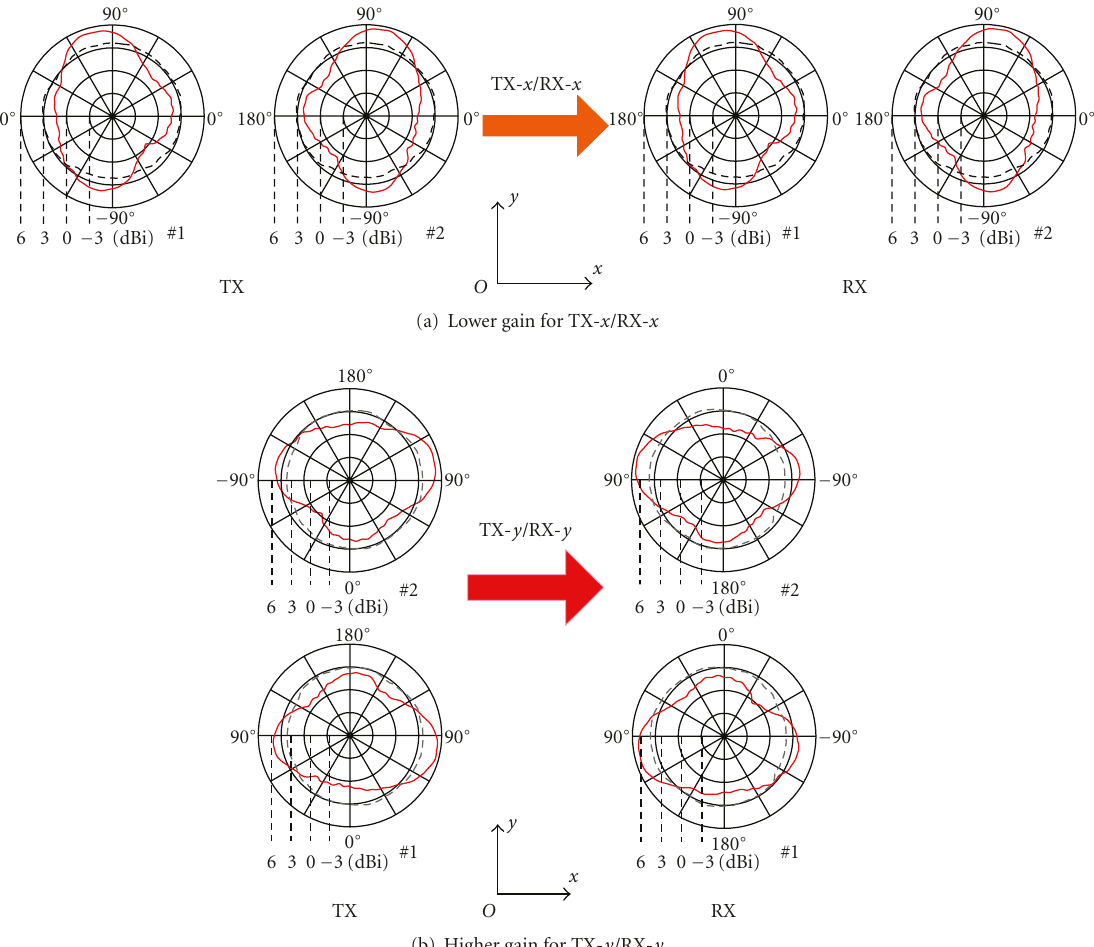
Figure 6: Antenna gain toward the direct wave for the case of AS = 0.5 λ